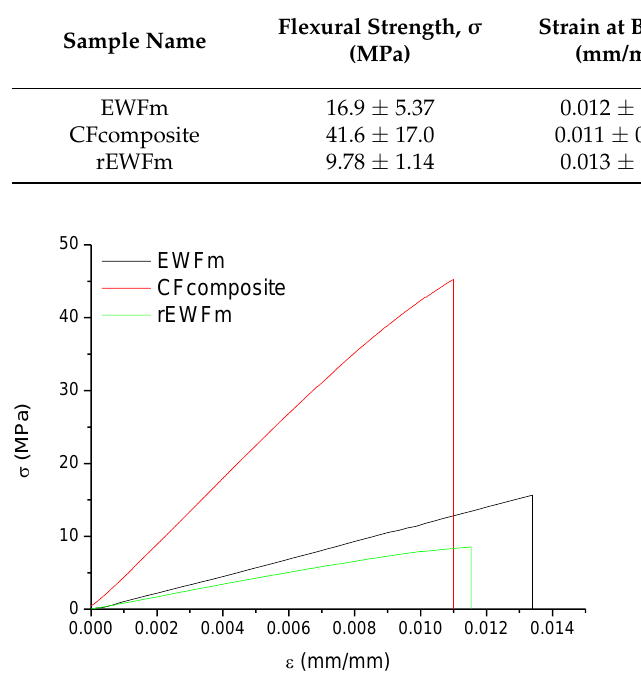
Figure 8. Flexural tests on EWF-based epoxy systems and